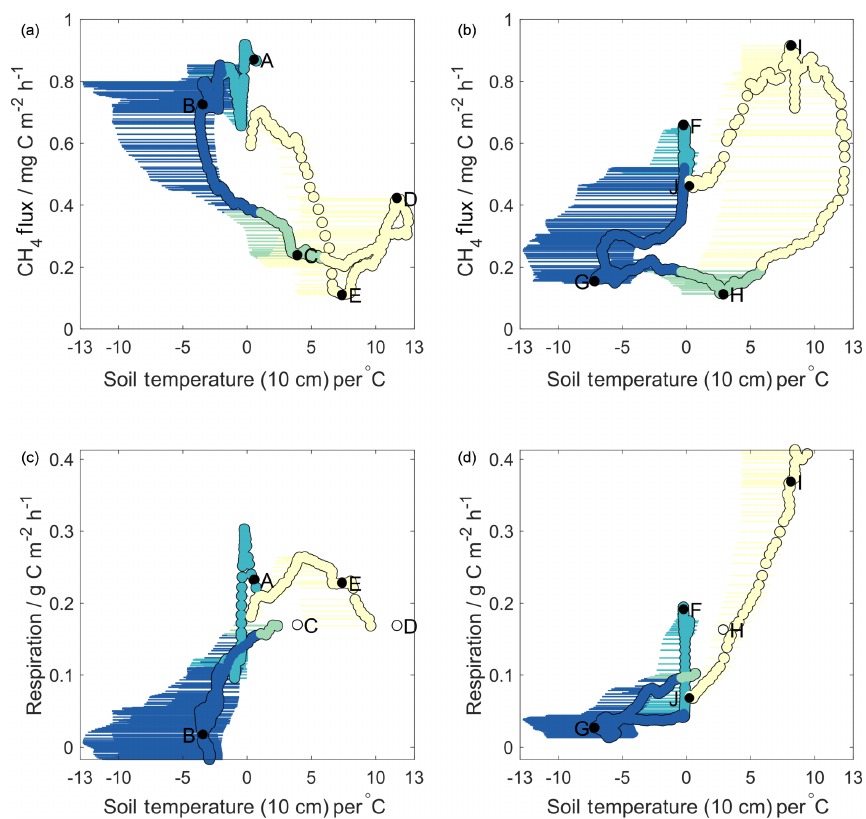
Figure 2. Methane (a, b) and respiration (c, d) fluxes against soil temperatures for Year 1 (a, c) and Year 2 (b, d) . Horizontal error bars represent the range of soil temperatures across all four sampling pits; circles represent values used in decision tree analysis (average of both Toolik Field Station profiles). Colours correspond to seasons as in Fig. 1. Lettering on methane flux plots is sequential in time and corresponds to that shown in Figs. 1 and 4. Lettering on respiration plots is given for the same times as that in the methane plots. Open circles represent times for which respiration data are missing – respiration values here are linearly interpolated in time between the closest known